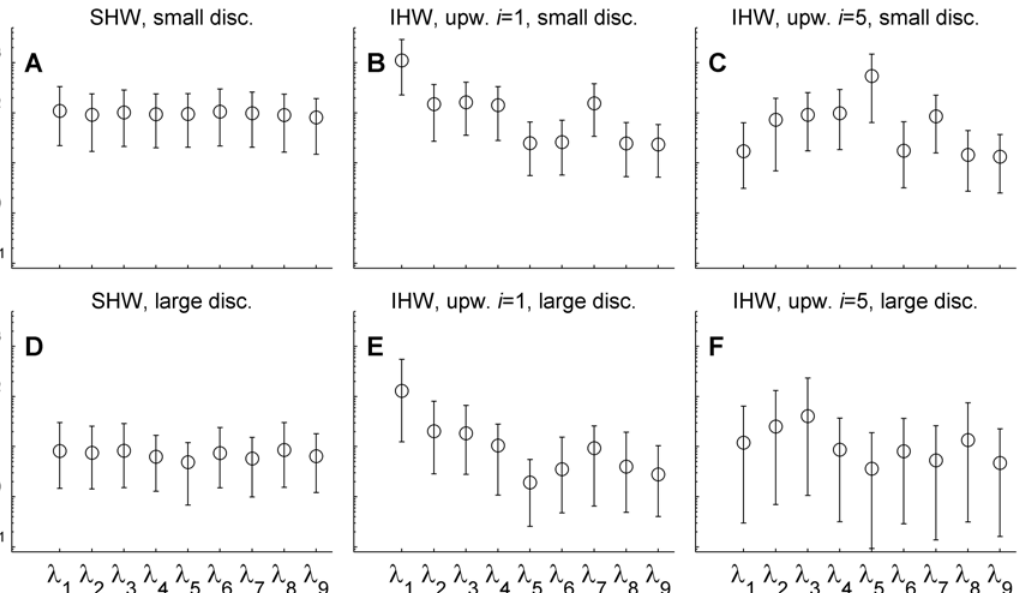
Fig 5. Marginal posterior estimates of weighting parameters, λ . Posterior means are indicated with circles and error bars indicate 95% central credibility intervals under a priori equal weights (left column panels), up-weighting of modeling assumption i = 1(middle column panels) and up-weighting of assumption i = 5 (right column panels). Results are shown for small and large discrepancy ensembles in top and bottom row panels,